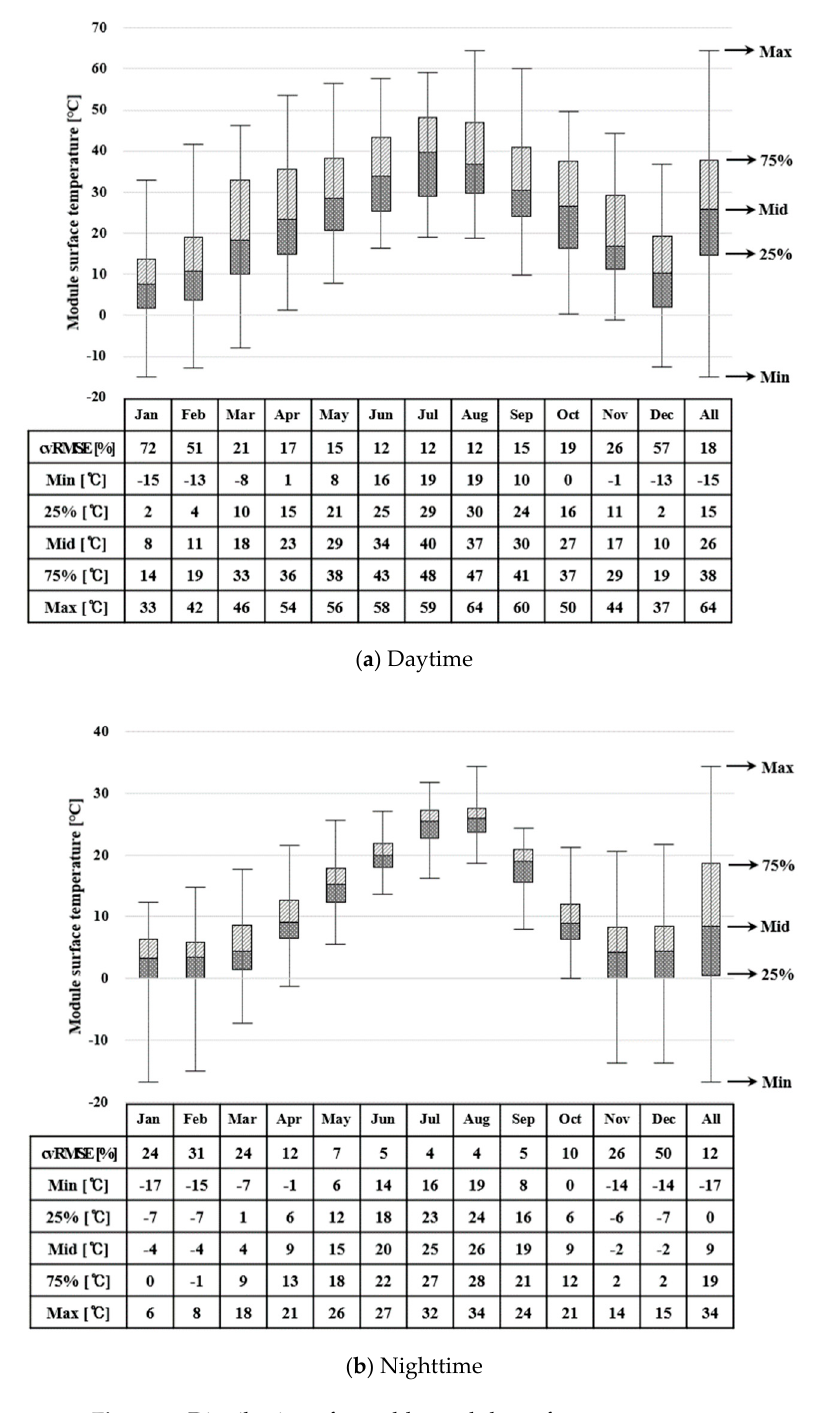
Figure 8. Distribution of monthly module surface temperatures.